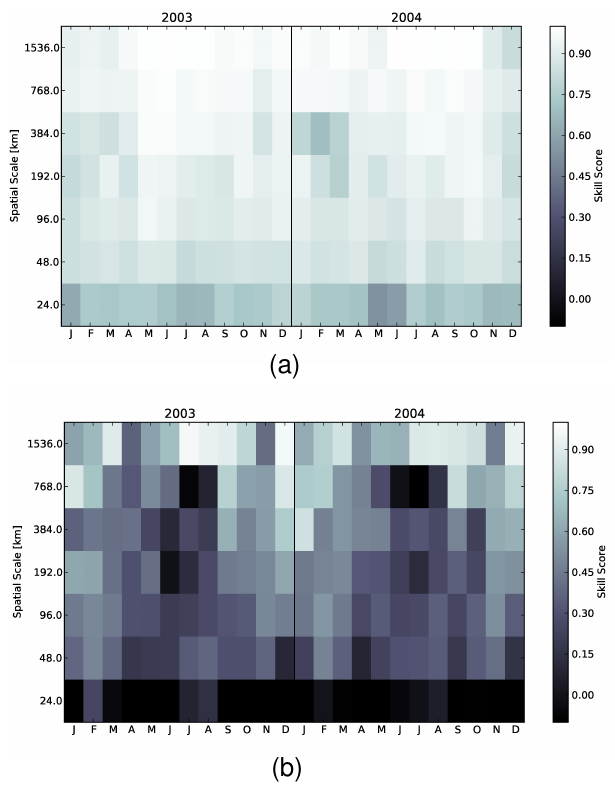
Fig. 3. Spatial scales versus time plot for the 5th quantile (80– 100%) 2003–2004. Sea surface temperature (a) and chlorophyll- a concentration (b) skill scores.